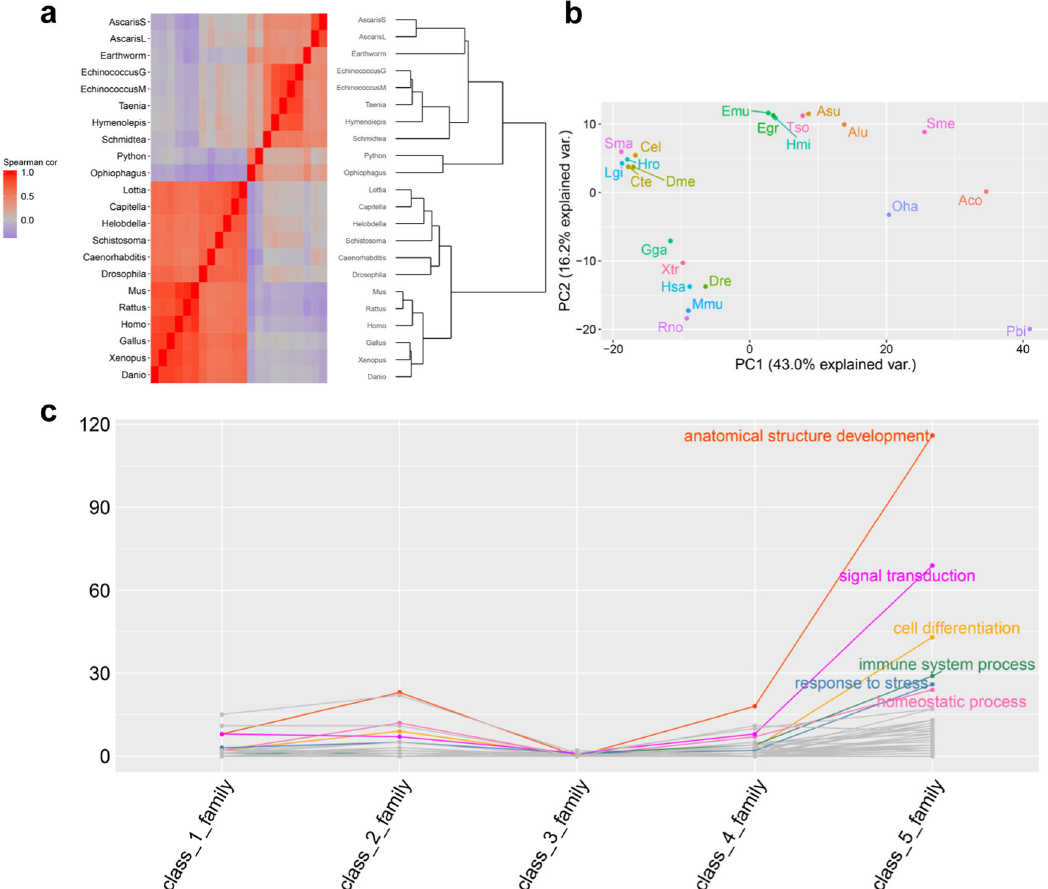
Fig. 3 Characteristics of multiple-copy gene families with accelerated rates of gene duplication and loss. a The heatmap and dendrogram plotted based on Spearman ’ s rank correlation coef fi cient matrix of gene member count of species of multiple-copy gene families with accelerated rates of gene duplication and loss. In the heatmap, the redder the color is, the stronger the correlation is. To plot the dendrogram, the distance between each pair of species is de fi ned as the difference value between 1 and the corresponding Spearman ’ s rank correlation coef fi cient. b Plot of PCA for 22 species, in which the fi rst two components account for 43% and 16% of variation, respectively. Components of species were calculated based on the count of gene member in families with signi fi cantly accelerated rates of gene duplication and loss. Along the fi rst component, Amynthas corticis is dissimilar with other two annelids. c The count distribution of enriched functions in each subset of gene families with accelerated rates of gene duplication and loss, in which enriched functions under the same GOSlim term are plotted as one line. The GOSlim term is labeled if the number of enriched functions attributed to it is larger than 20 in class_5_family. In this fi gure, AscarisL or Alu Ascaris lumbricoides , AscarisS or Asu Ascaris suum , Caenorhabditis or Cel